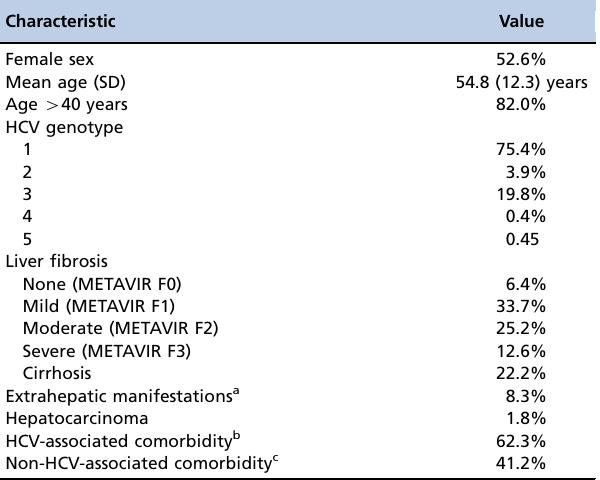
Table 1 - Demographics and clinical characteristics of the study population.